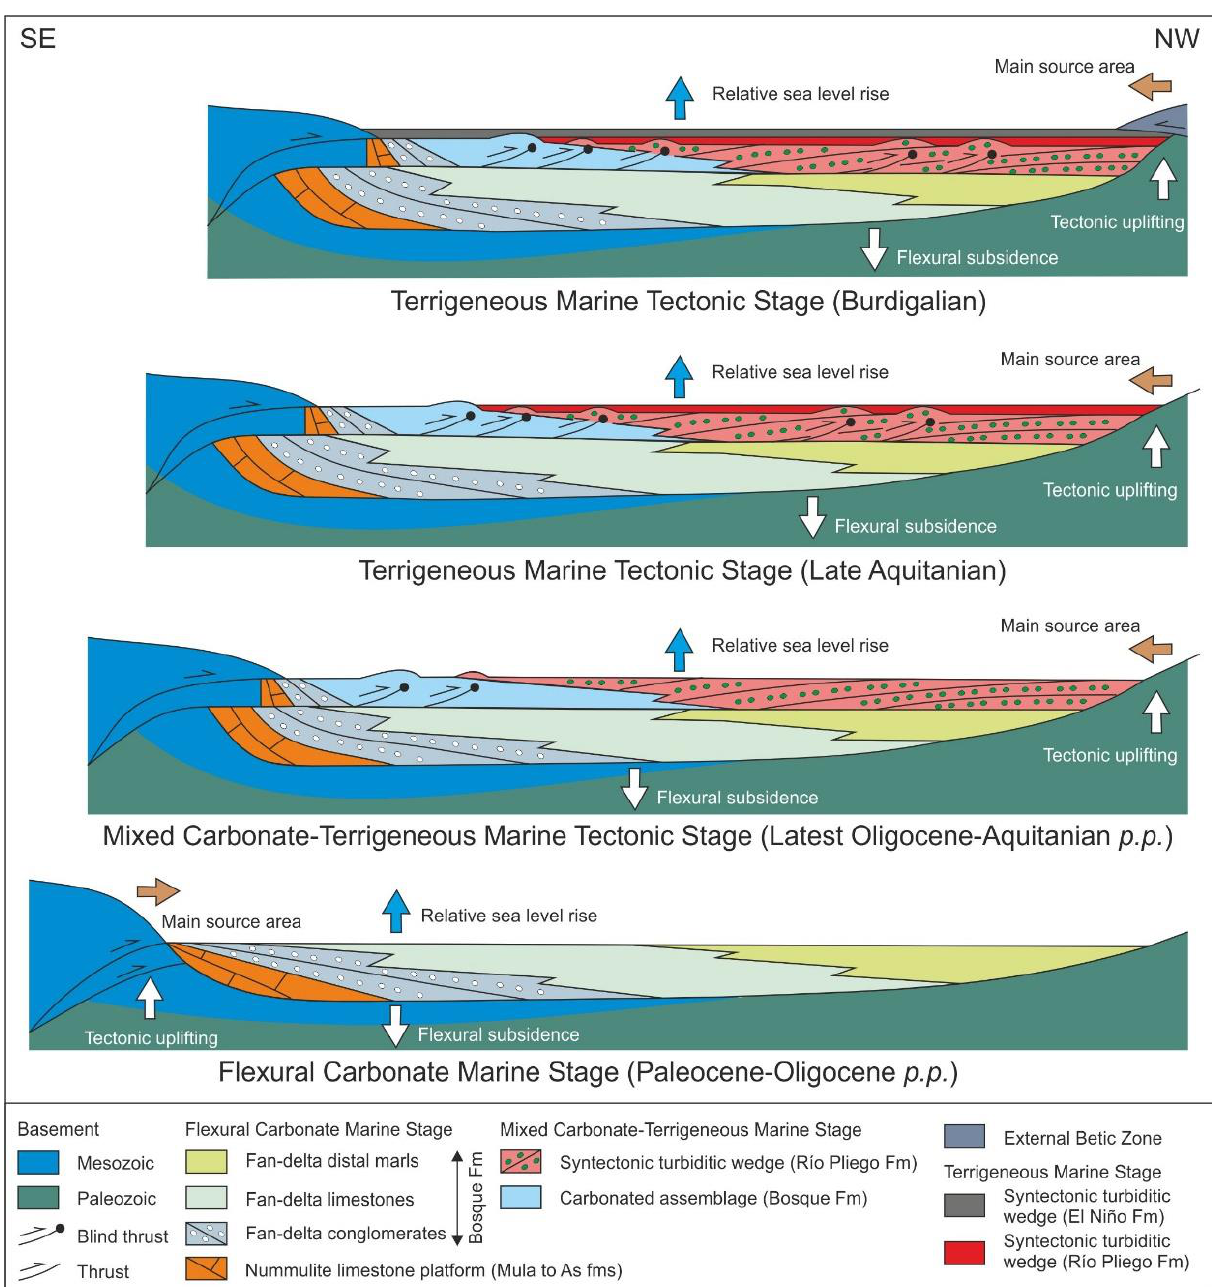
Figure 4. Tectono-sedimentary evolution of the Malaguide Cenozoic basin from Sierra Espuña area (modified from [12]).